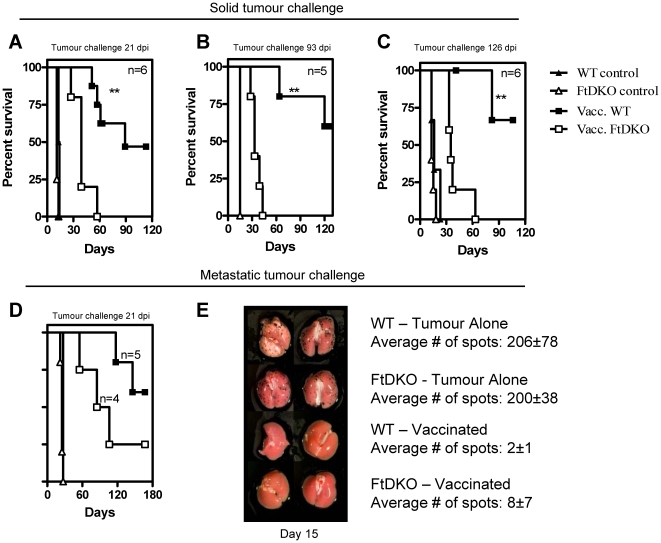
Prophylactic vaccination against B16-OVA/.C57BL/6J (WT) and FtDKO mice were vaccinated intravenously with LM-OVA and challenged with B16-OVA subcutaneously (A) 21 days, (B) 93 days or (C) 126 days post-infection. Survival curves were based on animals reaching a tumor size, 200 mm2. (D), Mice were challenged intravenously with B16-OVA, 21 days post LM-OVA infection. Survival was based on animals exhibiting a maximum weight loss of 20% or other clinical signs of illness. (E), Lung metastatic foci enumerated on day 15 post-tumor challenge in representative mice. Similar trend was noted for n = 5 mice/group. Significant differences were observed in panel A (p = 0.0082), panel B (p = 0.0015) and panel c (p = 0.03) by log-rank test.